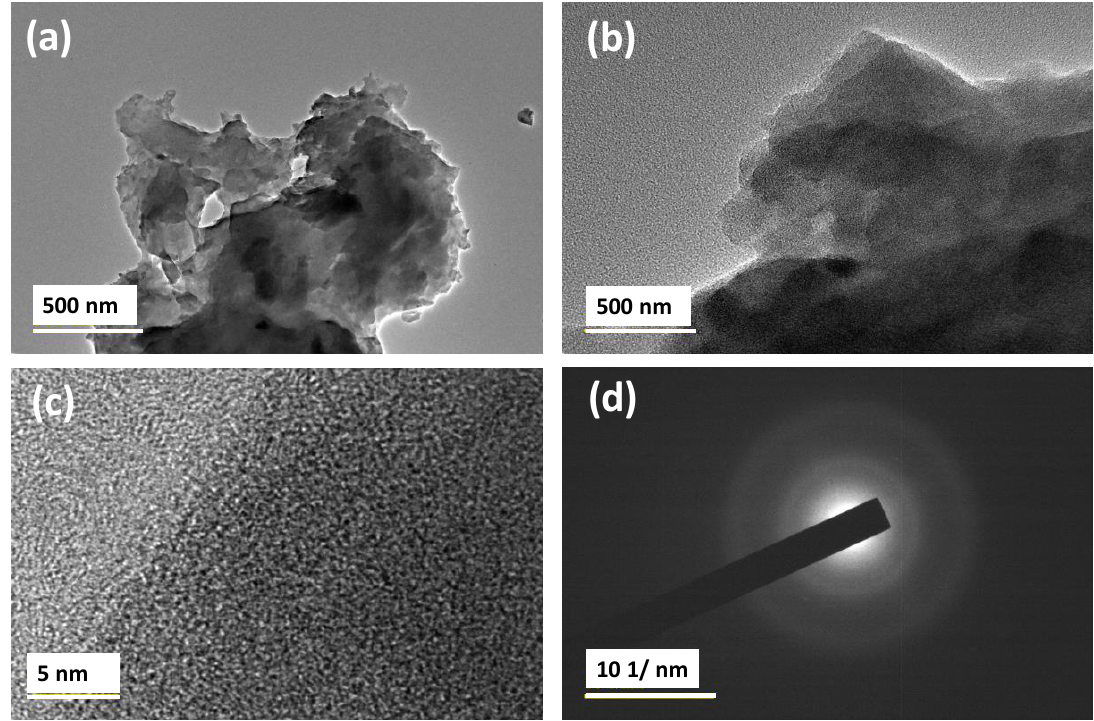
Figure 4. Y/Sialon thin films annealed at 100 °C TEM images at various magnifications ( a – c ) along Figure 4. Y / Sialon thin films annealed at 100 ◦ C TEM images at various magnifications ( a – c ) along with the corresponding selected area diffraction pattern from image ( d ). with the corresponding selected area di ff raction pattern from image ( d